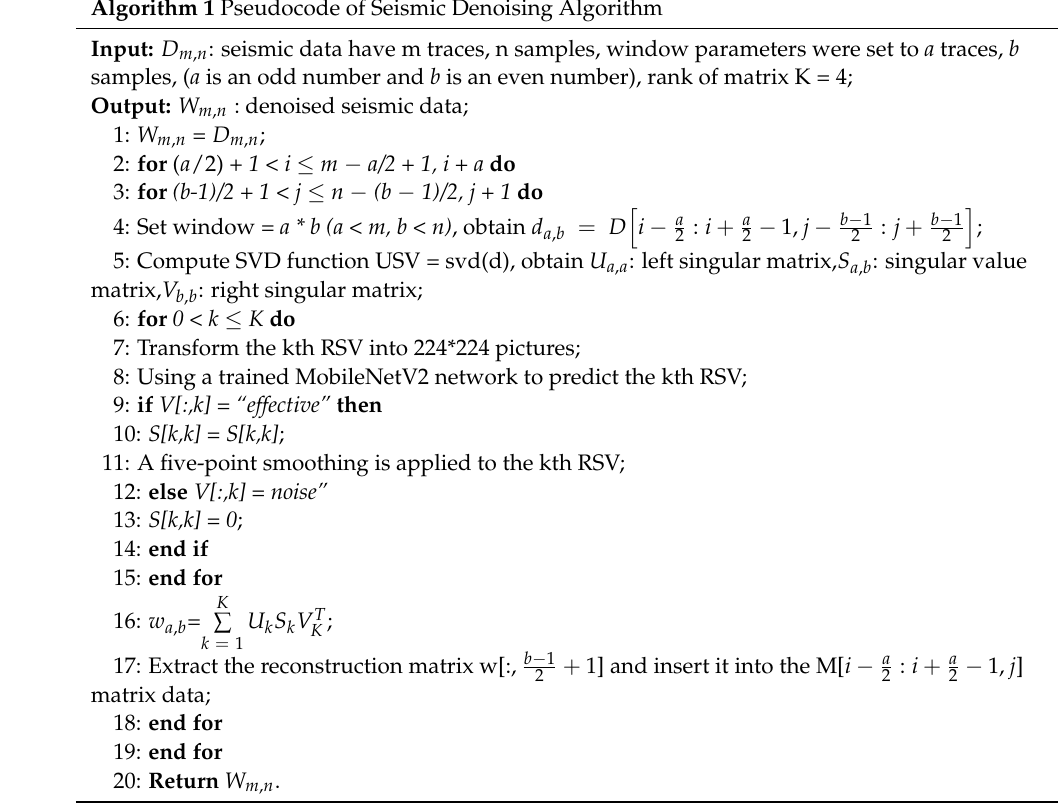
Algorithm 1 Pseudocode of Seismic Denoising